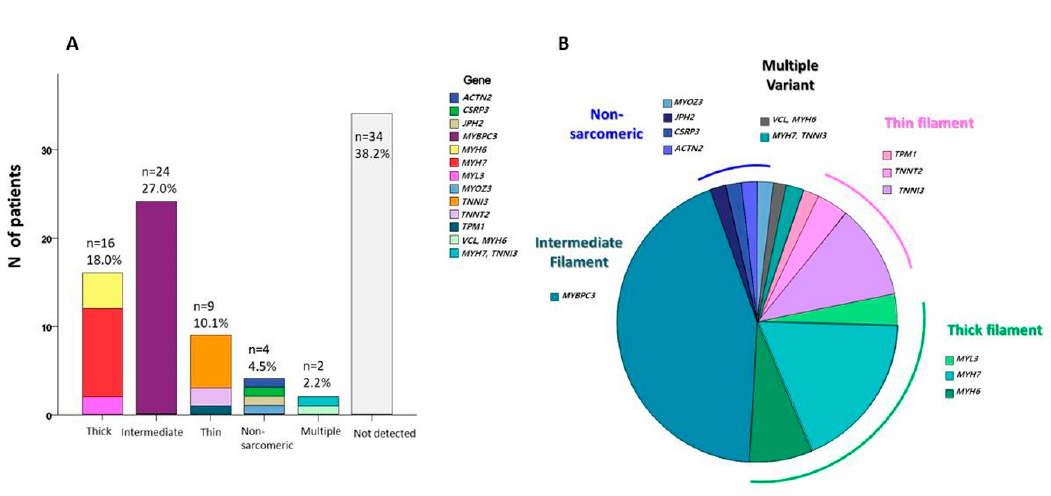
Figure 2. Distribution of affected variants identified for each analyzed gene: ( A ) Distribution of affected variants classified by gene variant location and ( B ) subgroup analysis of distribution of affected variants among the detected variants.